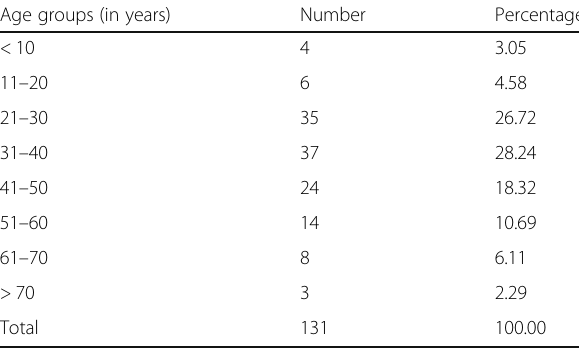
Table 3 Distribution of study subjects according to the age